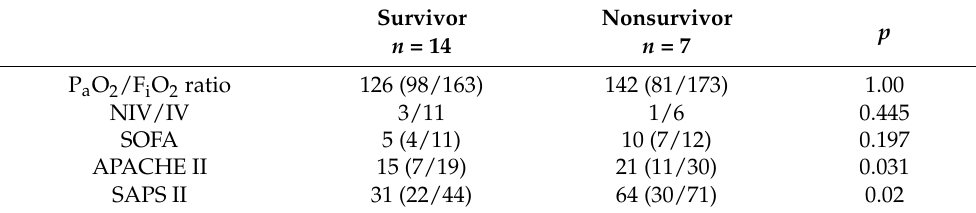
Table 2. Survivor and nonsurvivor medical conditions at ICU admission.